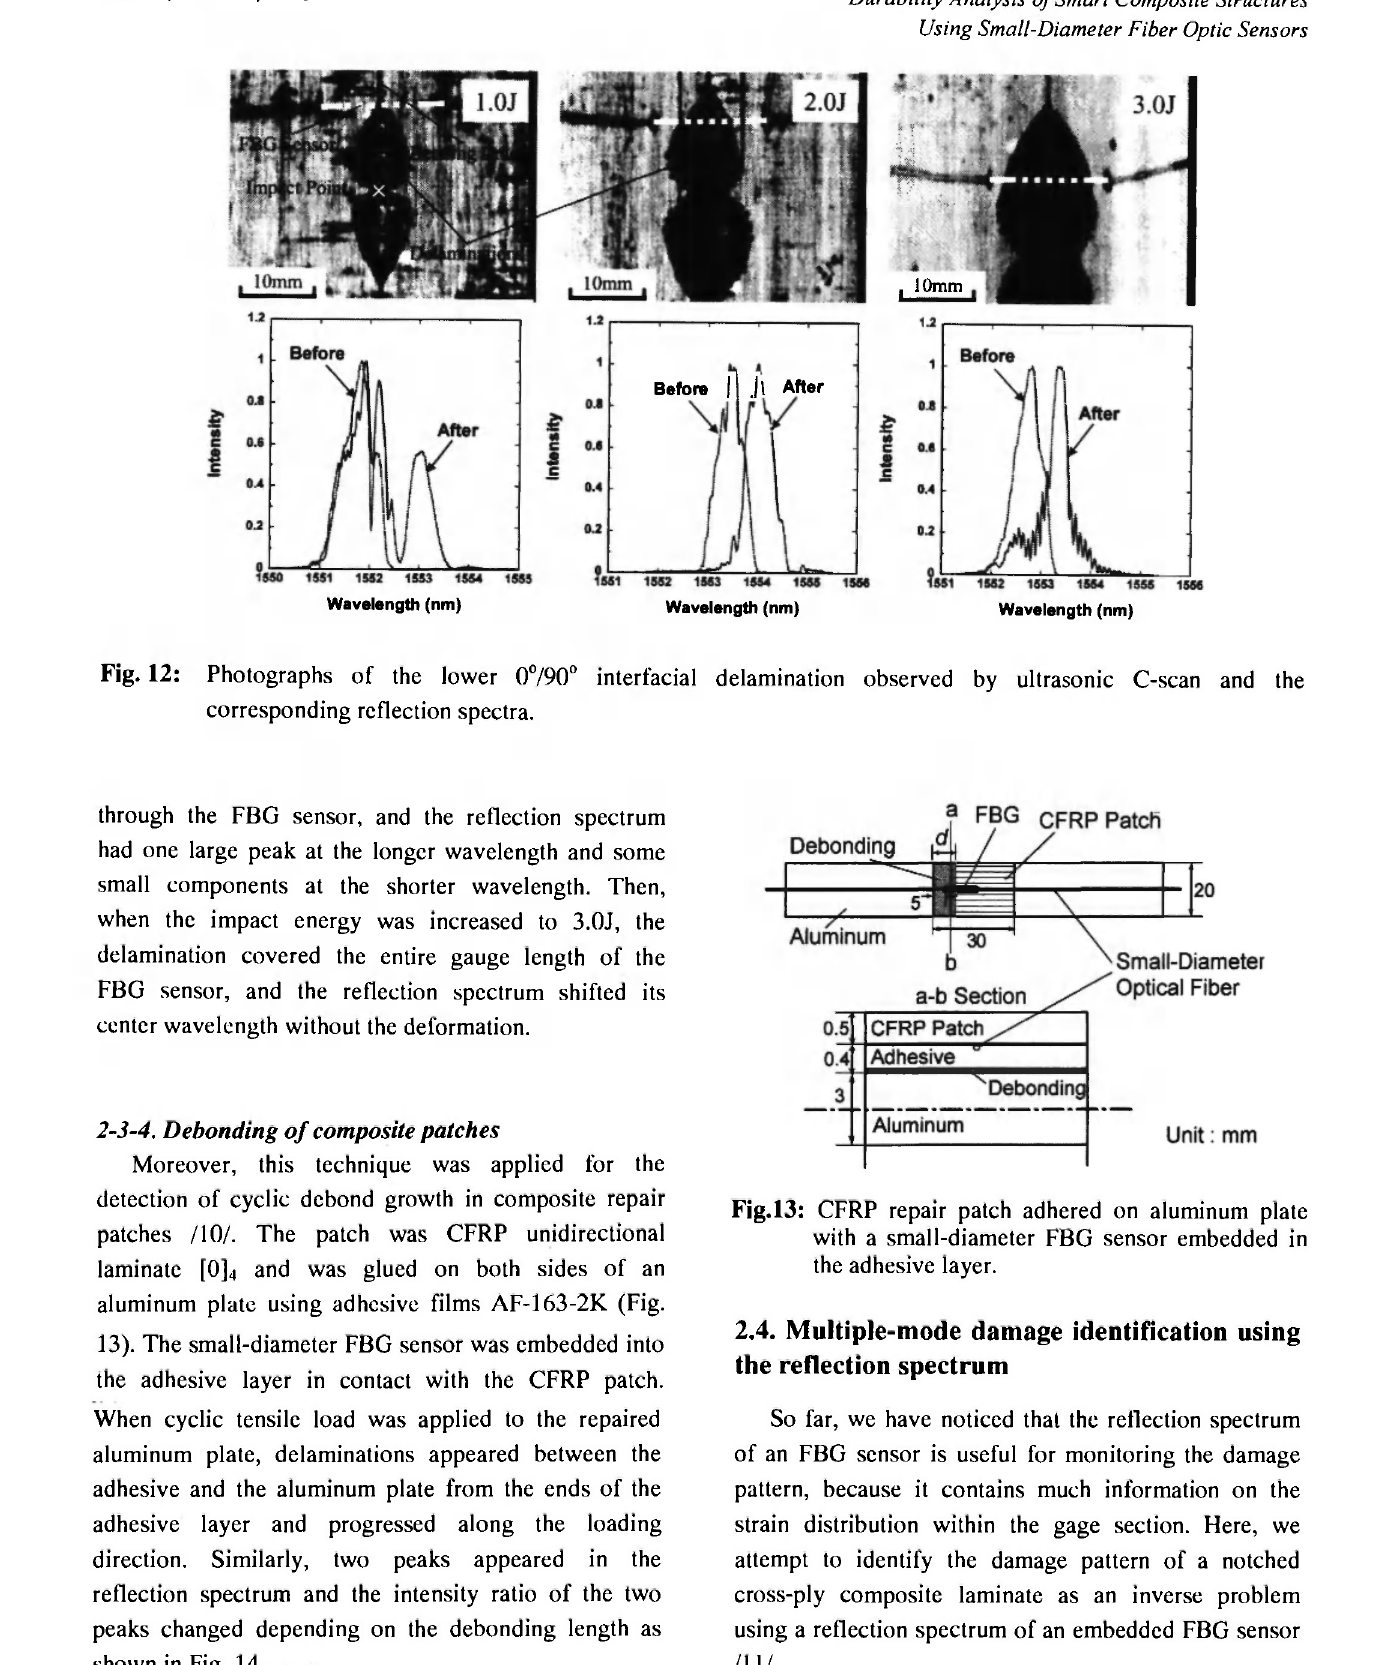
Fig.13: CFRP repair patch adhered on aluminum plate with a small-diameter FBG sensor embedded in the adhesive